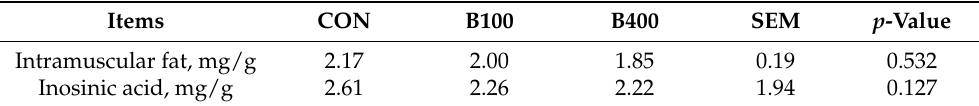
Table 9. Effects of dietary supplementation with bilberry extract on the content of intramuscular fat and inosinic acid in breast muscle of yellow-feathered chickens at 63 d 1